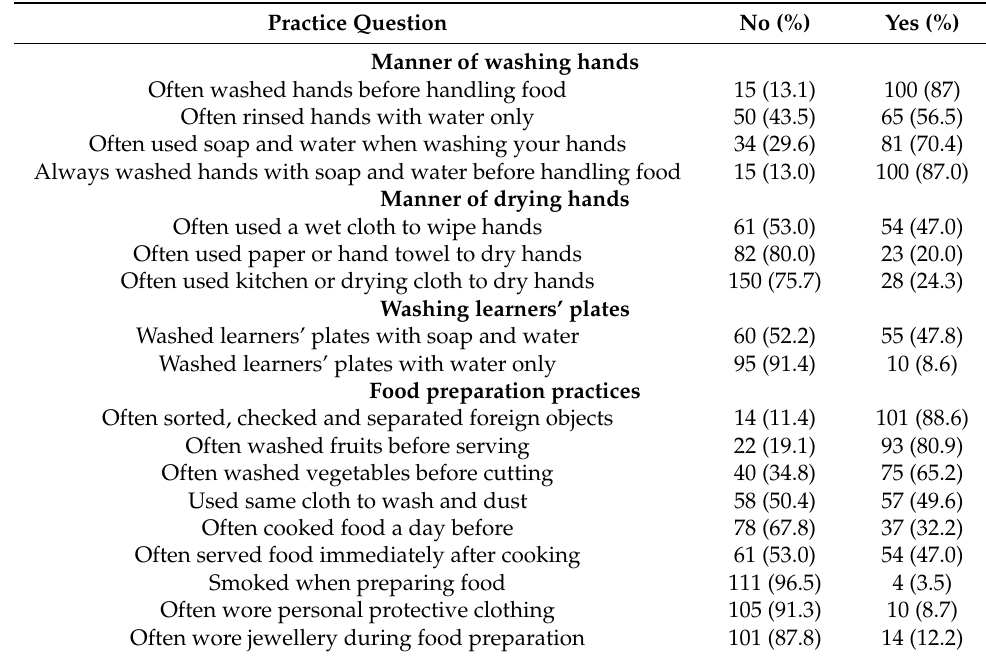
Table 3. Volunteer food handlers’ food safety practices (n =